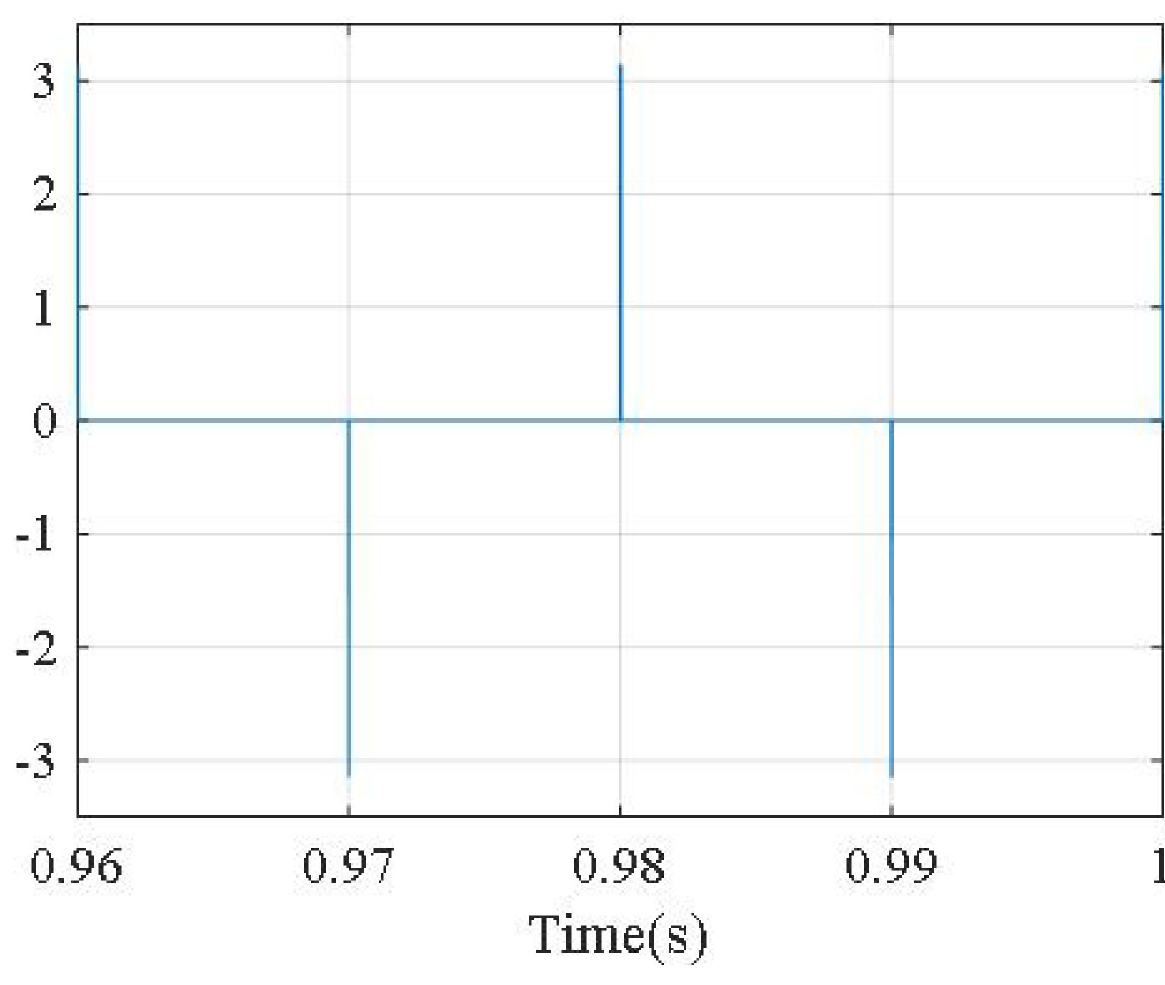
Fig 11. Phase shift angle between u sa , and i sa .